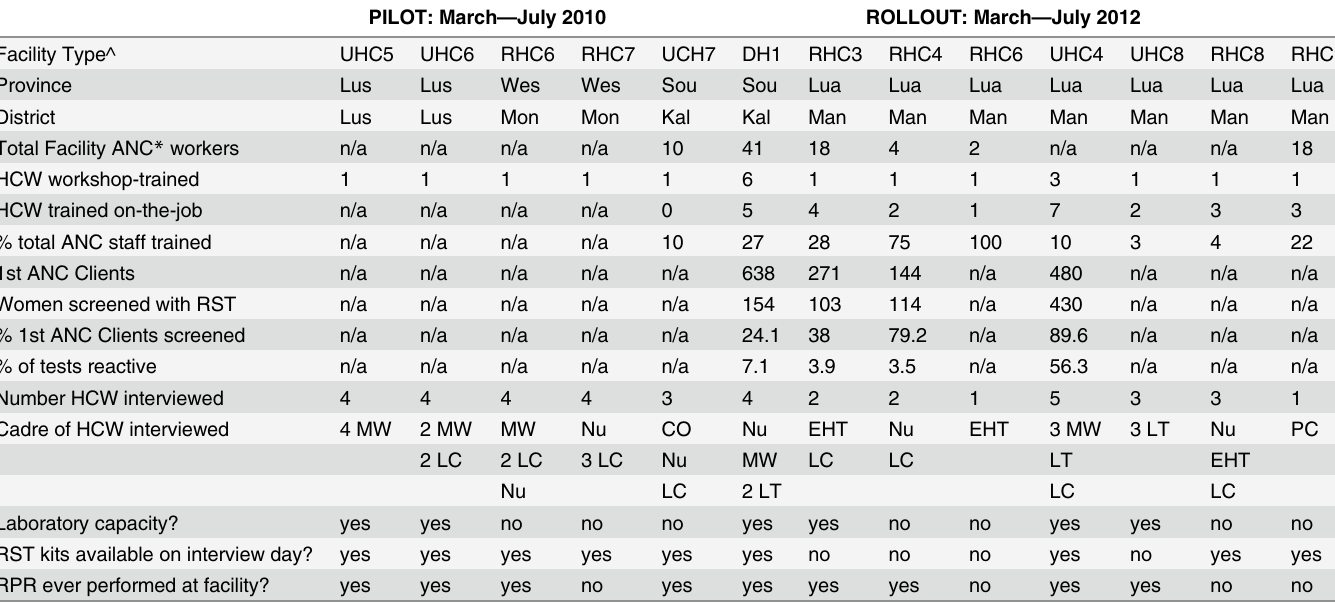
Table 2. Health care worker and facility data for pilot and rollout evaluation